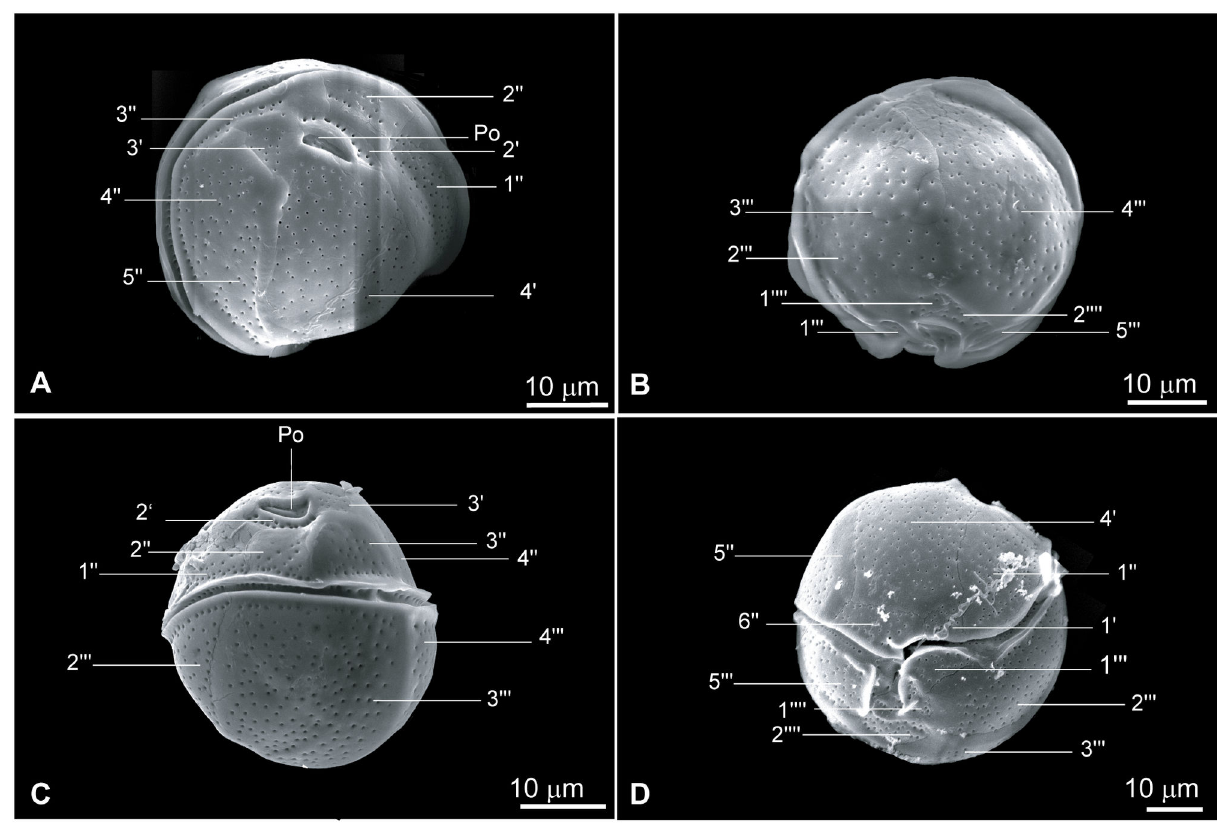
Figure 7. Scanning electron micrographs showing plate arrangements of Coolia tropicalis (NQAIF90), following Besada's plate notations [36]. A: apical view, B: antapical view, C: dorsal view, D: ventral view, . doi: